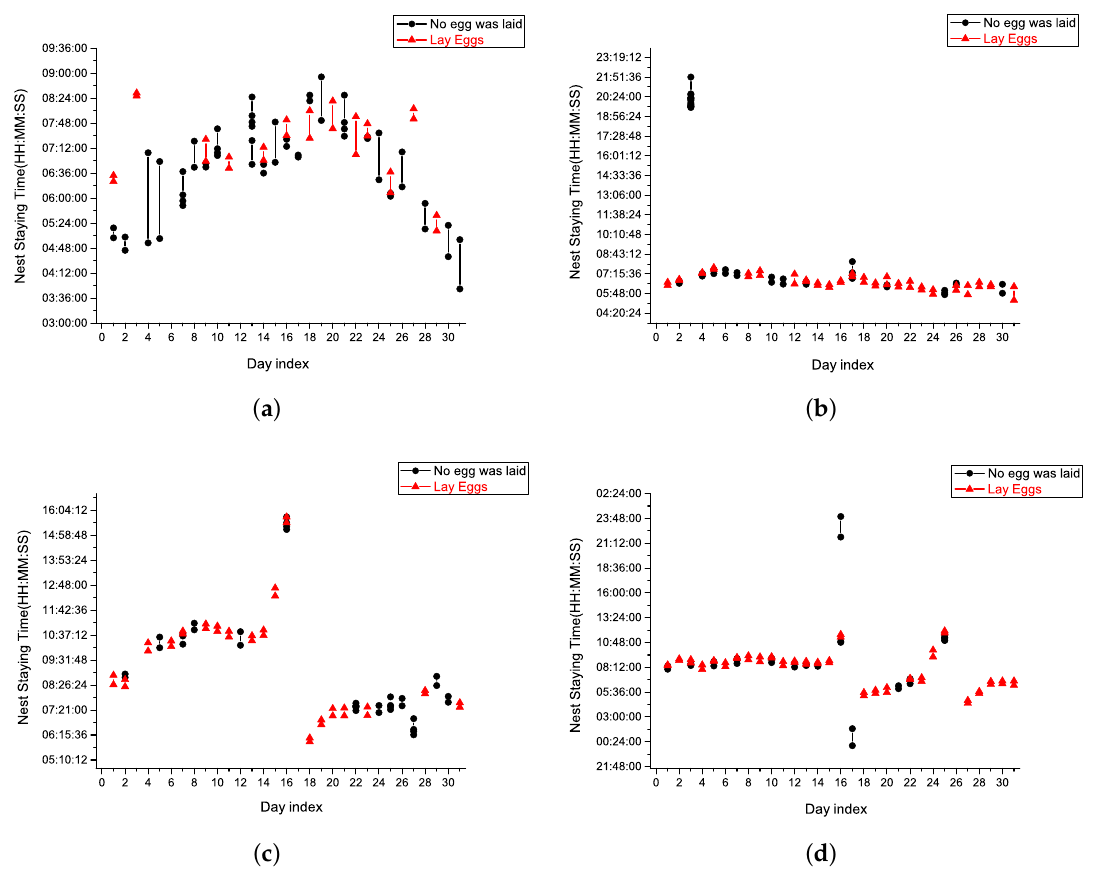
Figure 9. Individual hen laying behavior and the corresponding nest box visit duration. ( a ) Hen with